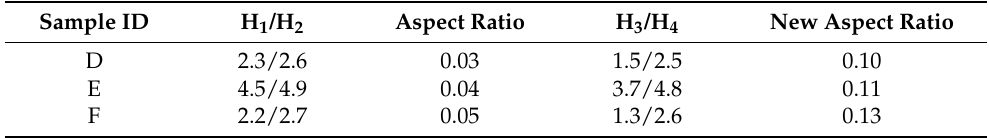
Table A2. Structure sizes measured for samples with increased initial film thickness (sample E) and radical polymerization inhibitor t-butyl hydroquinone (TBHQ) in the film (sample F), as compared Table A3. Structure height of the surface reliefs for line pattern (#1), square pattern (#2), and to sample D. The periods are set to be 10 µm for all three samples. checkboard pattern (#3) used for LC cells in the polymer-free